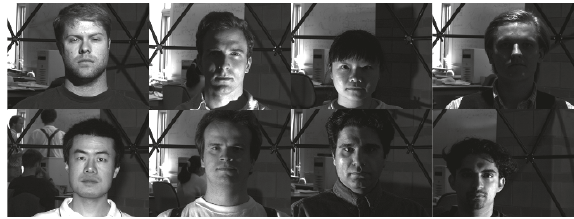
Figure 10: Sample images from the Extended YaleB